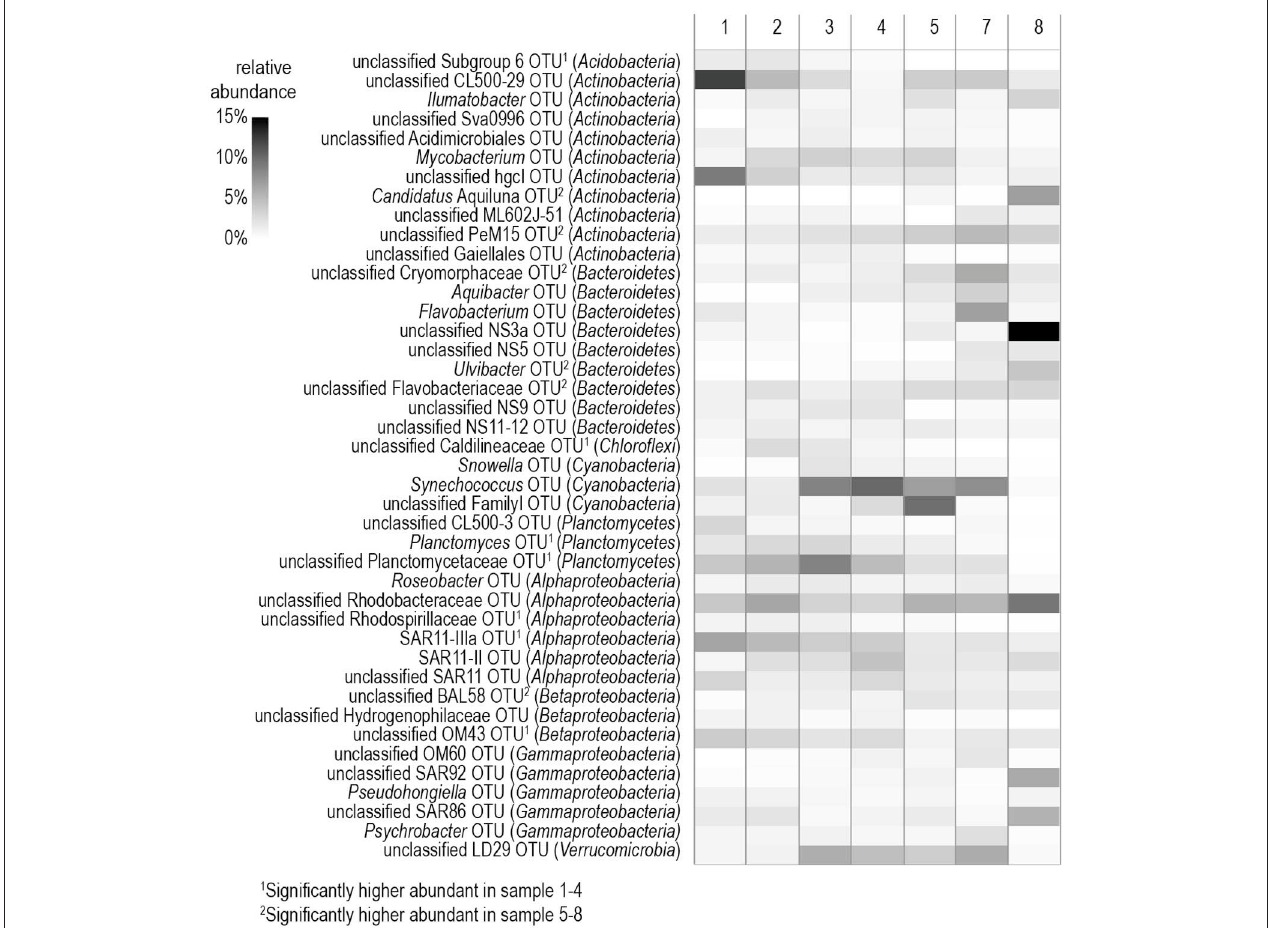
FIGURE 5 | Heatmap of the 75% most abundant operational taxonomic units (OTUs) detected in samples from the different stations. The affiliation with the respective phylum is shown in